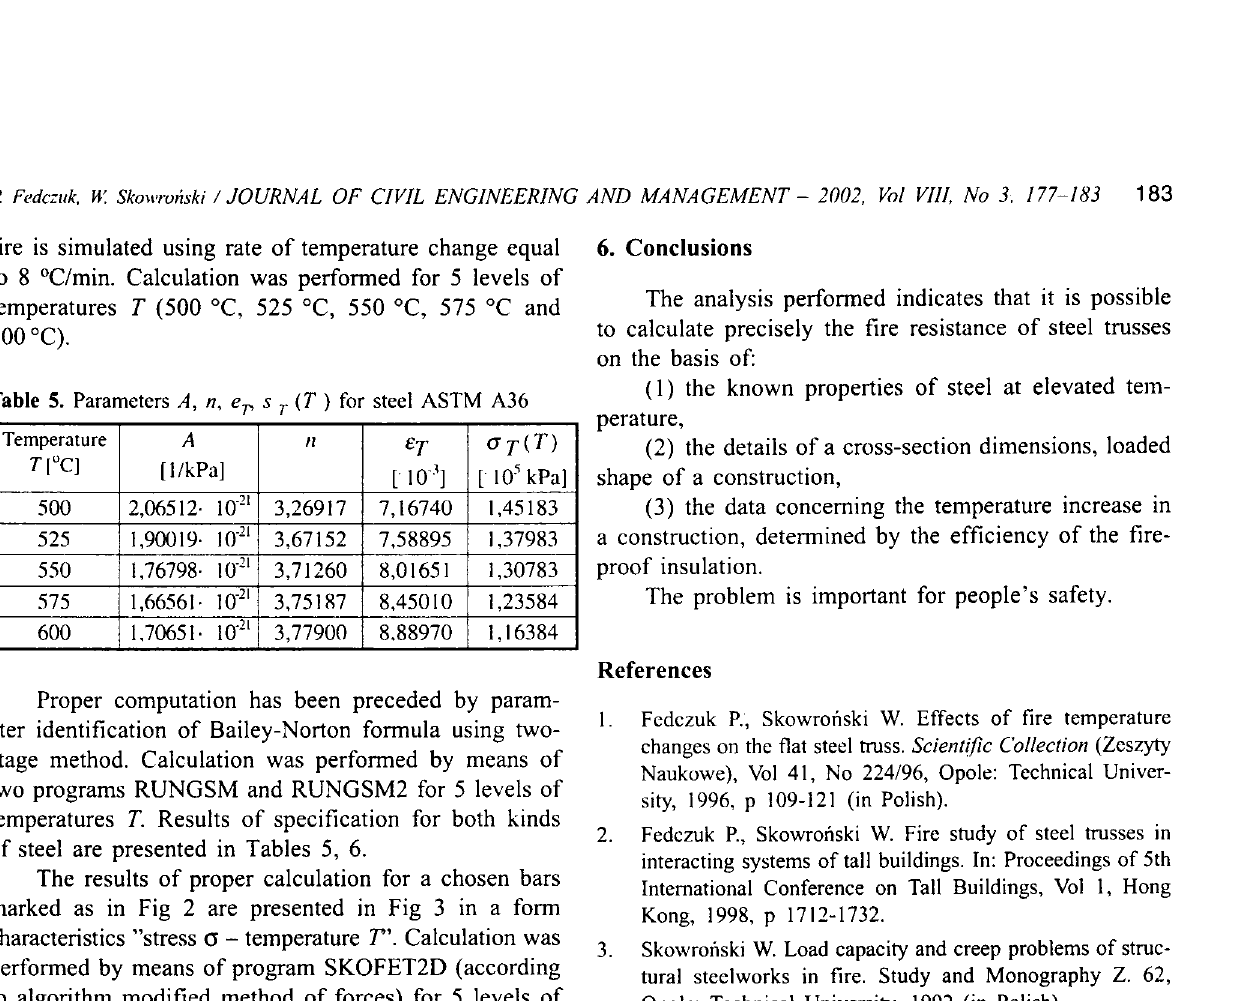
Table 6. Parameters A*, n *, e* T' R"' (T ) for steel ASTM